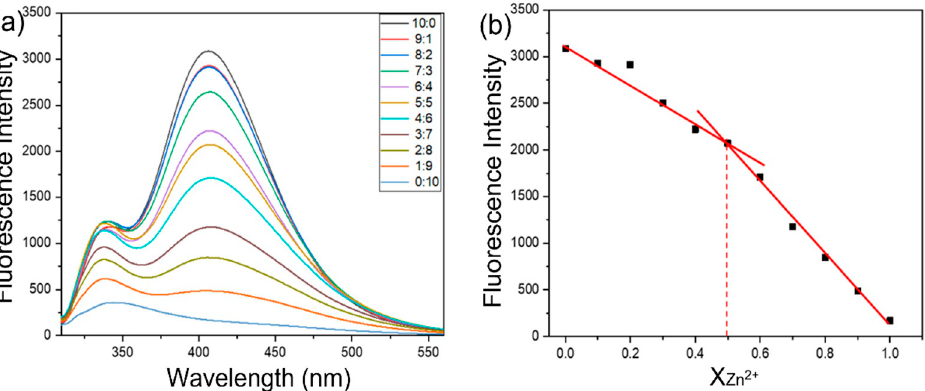
Figure 2. ( a ) The fluorescence titration of Zn(II) with TP5 , [ TP5 ] + [Zn 2+ ] = 2 × 10 − 5 M. ( b ) Job’s plot curve from spectra ( a ).